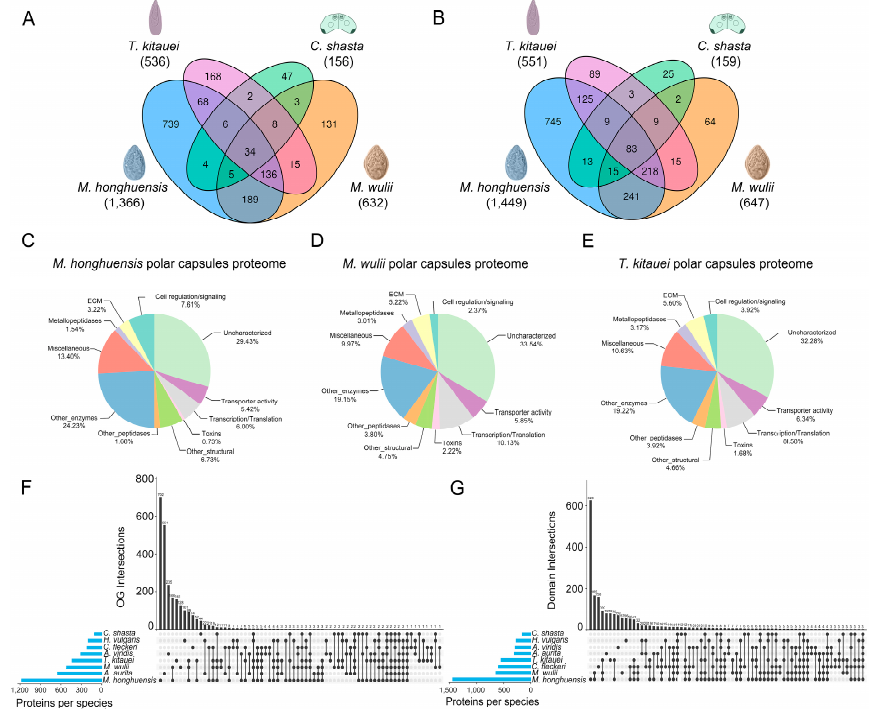
Figure 2. Comparative analysis of the newly obtained Myxobolus honghuensis , Myxobolus wulii , and Thelohanellus kitauei proteomes and published nematocyst proteomes for the myxozoan Ceratonova shasta and free-living cnidarians Hydra vulgaris , Anemonia viridis , Aurelia aurita , and Chironex fleckeri . Venn diagram showing the number of proteins ( A ) and InterPro domains ( B ) shared among the nematocyst proteomes of M. honghuensis , M. wulii , T. kitauei , and C. shasta . ( C – E ) Distribution of functional nematocyst proteomes. Functional protein classes of the M. honghuensis , M. wulii , and T. kitauei nematocyst proteomes. Upset diagram showing the number of proteins ( F ) and InterPro domains ( G ) shared among the eight cnidarian nematocyst